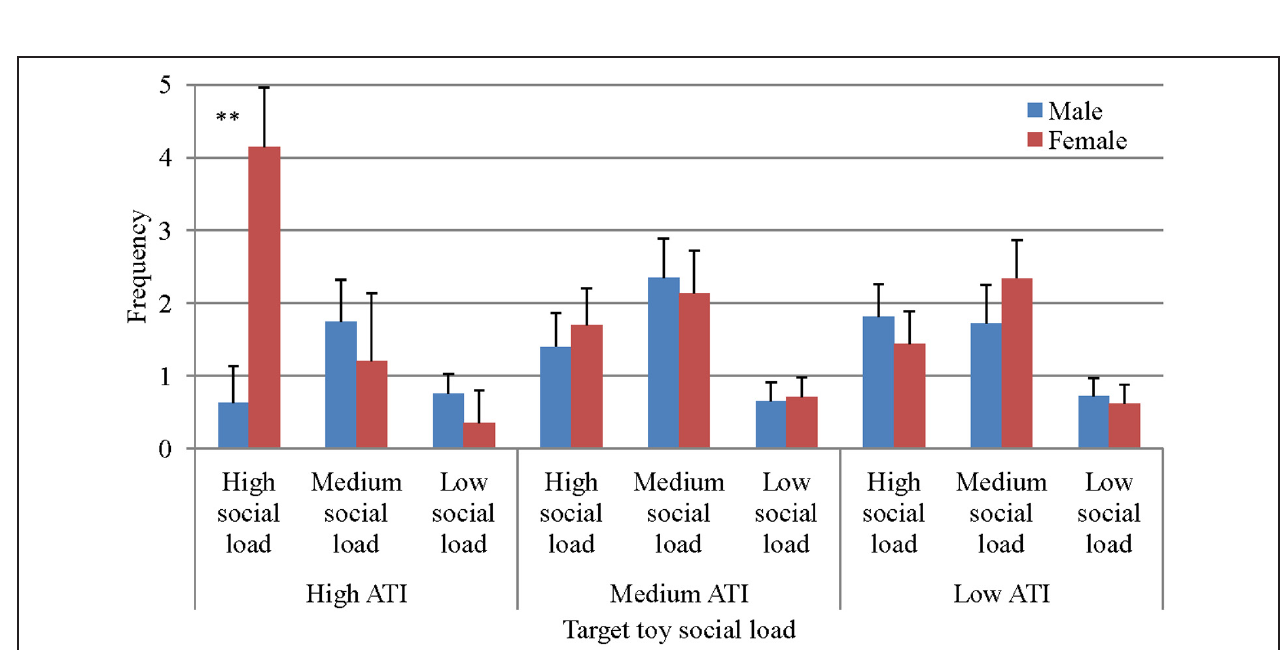
FIGURE 1 | JABS frequencies as a function of gender and social load. ∗∗ p < 0 . 05.